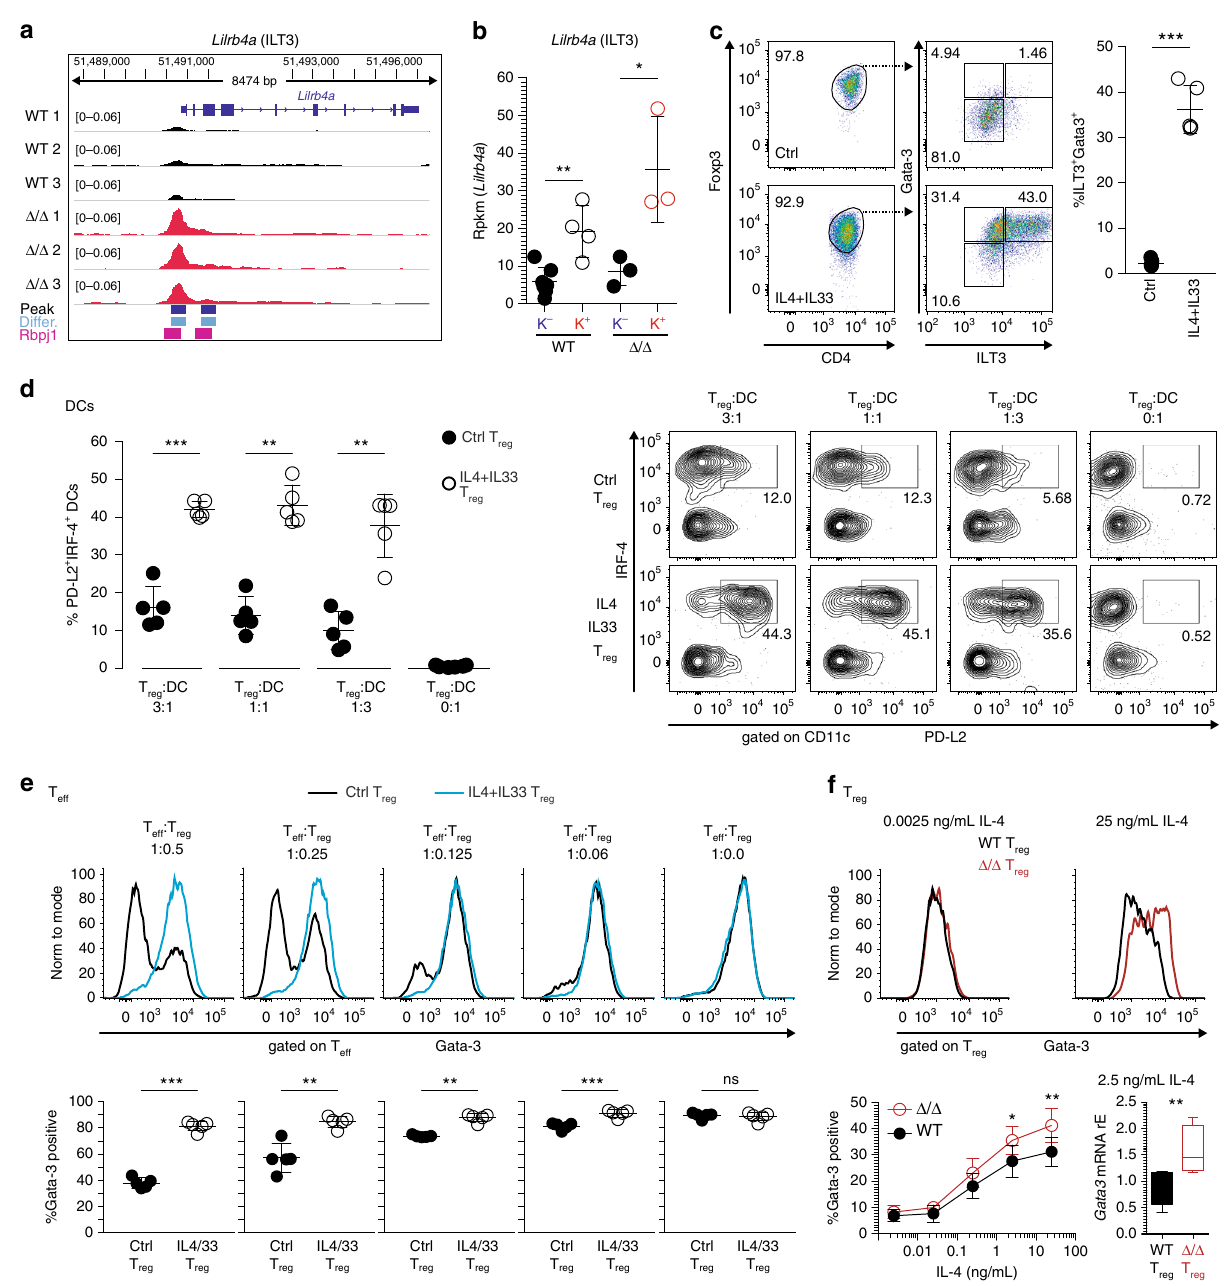
Fig. 9 ILT3 + Gata3 + T H 2-biased T reg cells fail to suppress T H 2 polarization. a ATAC-seq genome browser track for the Lilrb4a gene (encoding for ILT3), with WT Klrg1 − T reg cell data in black and Δ / Δ Klrg1 + T reg cell data in red. Gene information on top. Height indicates normalized ATAC-seq signal, scale shown in brackets. All samples group-normalized. Below, all peaks (black squares), differential peaks (blue squares), and de novo Rbpj-binding motif (purple). b Lilrb4a gene expression based on RNA-seq data derived from WT and Δ / Δ Klrg1 − and Klrg1 + T reg populations ( n = 3 – 7, unpaired t -test). c WT T reg cells (CD4 + CD25 + Foxp3-GFP + ) expanded for 6 days in vitro with IL-4 and IL-33 (IL4 + IL33 T reg group) or without (control, Ctrl T reg group). After 6 days, expression of Foxp3, Gata-3, and ILT3 measured by fl ow cytometry. Quanti fi cation right ( n = 4, unpaired t -test). d 16-h DC polarization assay with different numbers of Gata-3-expressing T reg cells or control T reg cells (Ctrl T reg ) as in c . Expression of PD-L2 and IRF-4 in DCs (CD11c + MHCII + ) measured by fl ow cytometry. Quanti fi cation left (paired t -test, n = 5) and representative dot plots right. e 96-h T-effector cell (T eff ) polarization assay with 20 ng/mL IL-4 and different numbers of either Gata-3-expressing T reg cells (blue line) or control T reg cells (black line) as in c and d , in the presence of DCs. Representative histograms showing Gata-3 expression in T eff cells (CD4 + CD11c - MHCII − CD25 + Foxp3 − ) on top, quanti fi cation below ( n = 5, paired t -test). f T reg cells (CD4 + CD25 + Foxp3-YFP + ) isolated from healthy, unaffected Δ / Δ and WT animals and stimulated with escalating doses of IL-4 followed by FACS measurement of Gata-3 protein. Representative histograms on top show Gata-3 expression in WT (black) or Δ / Δ (red) T reg cells, treated with 0.0025 ng/mL IL-4 (left) or 25 ng/mL IL-4 (right). Below, Gata-3 expression across different doses. Statistics based on two-way ANOVA with Bonferroni post-test ( n = 6). Lower right, qPCR-based veri fi cation of fl ow cytometry data for Gata3 with 2.5 ng/mL IL-4 ( n = 4, paired t -test). Data are representative of two or more independent experiments with individual mice ( c – f ) or a single experiment with several individual mice ( a , b ). Source data are provided as a Source Data fi